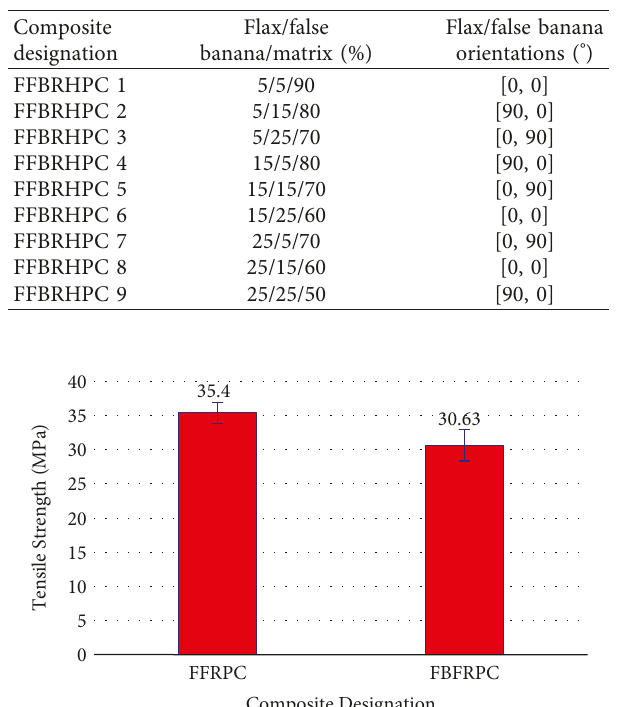
Table 5: Composition of composite designations.